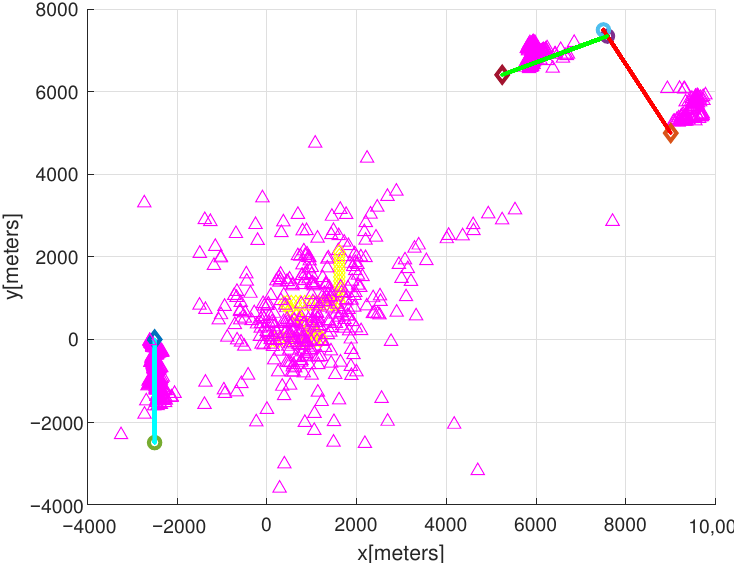
Figure 2. This figure shows the simulation result with interference points. We set λ k = 1, which implies that, on average, one interference point is generated at each sampling-stamp. The estimated target position is marked with magenta triangles. Before the observer maneuver at 125 s, true target positions are not tracked by target estimations (magenta triangles). However, as time goes on, true target positions are tracked by target estimations.